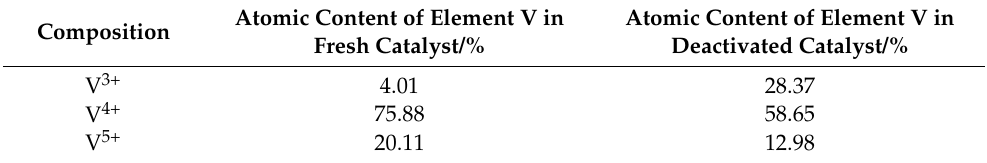
Table 3. Content of V elements with different valence in catalyst before and after